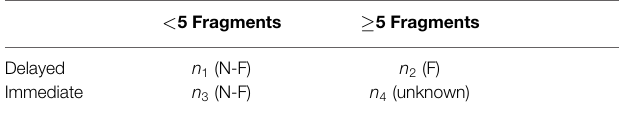
TABLE 4 | Criteria 3 (C3) .